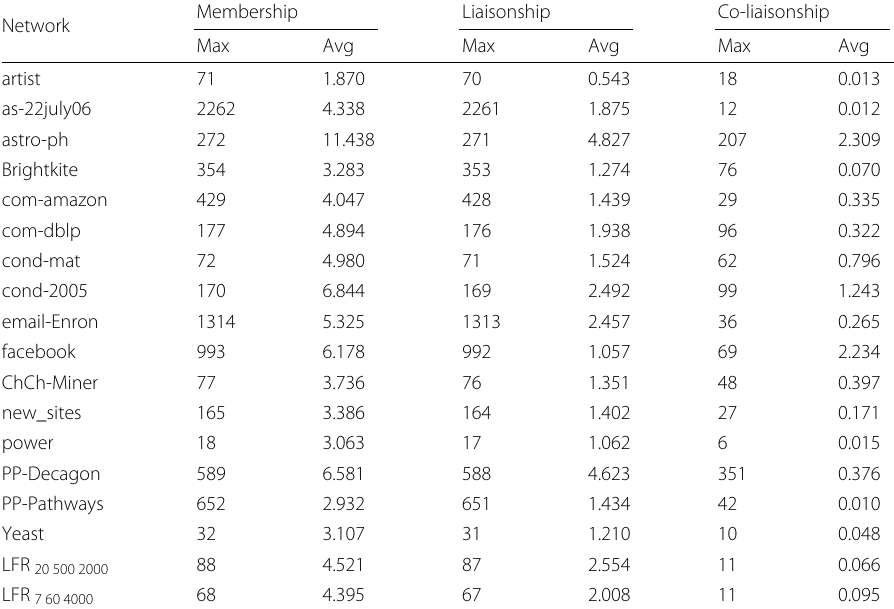
Table 14 Memberships in real-world networks Network